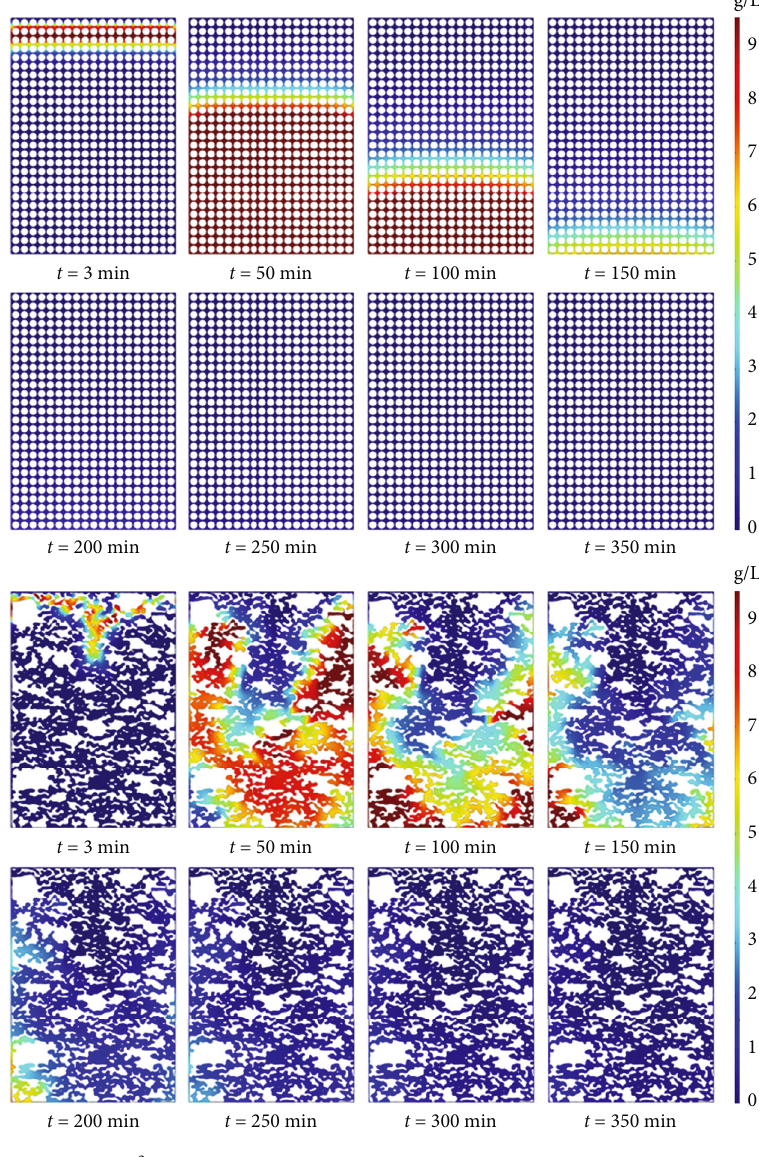
Figure 7: RE 3+ ion migration processes in the NMRI model and uniform